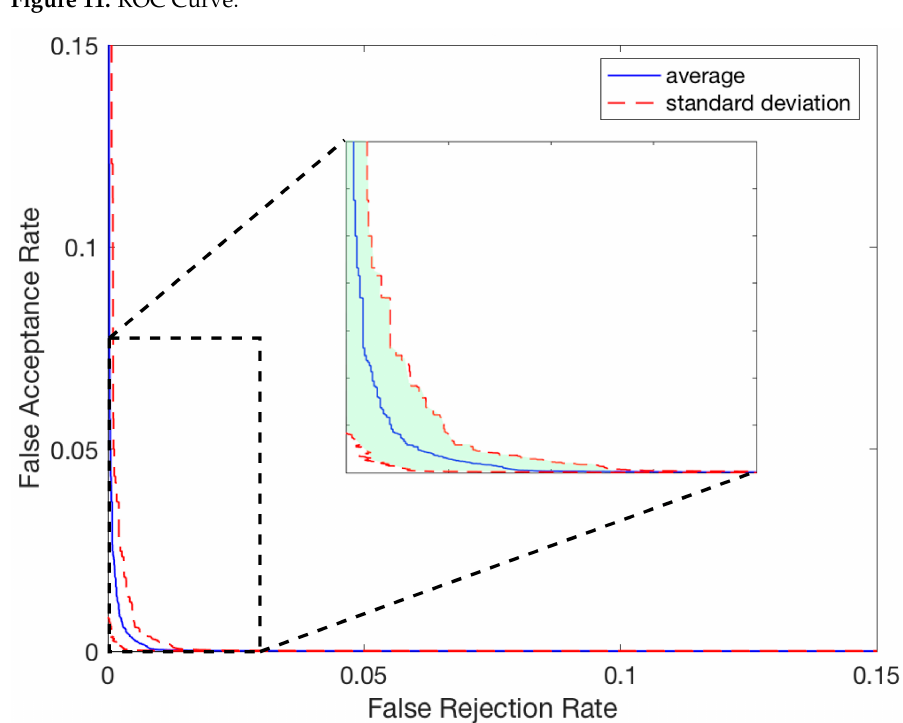
Figure 11. ROC Curve.